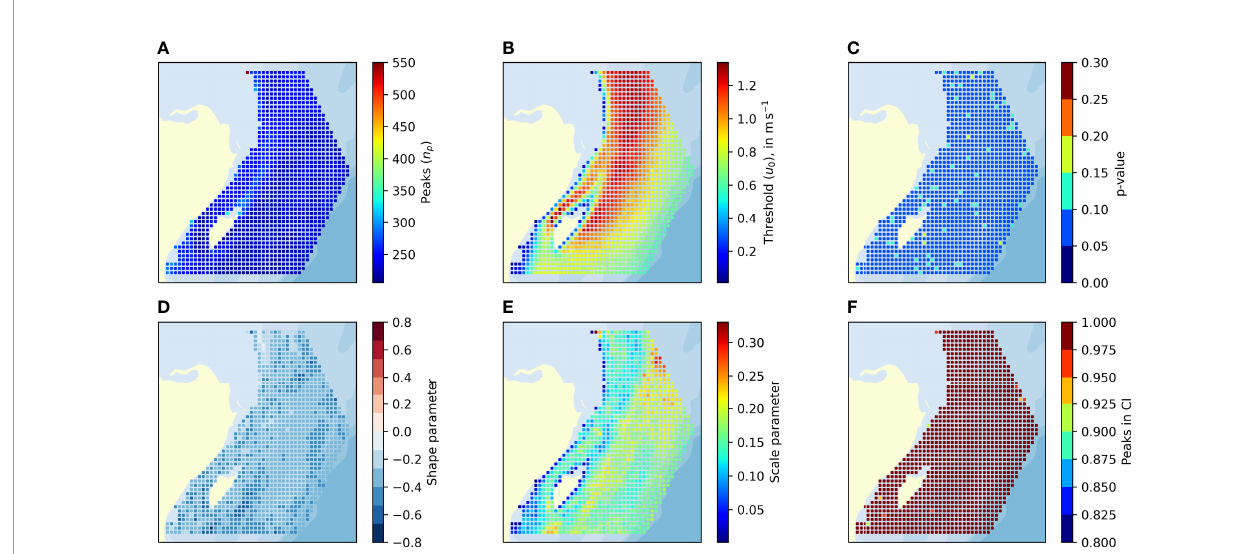
FIGURE 6 | Statistical data for the GPD fi t. (A) Number of identi fi ed peaks. (B) Selected thresholds. (C) p-value for the selected thresholds. (D) Shape factor for GPD fi t to POT. (E) Scale factor for GPD fi t to POT. (F) Share of peaks within the CI 95% .